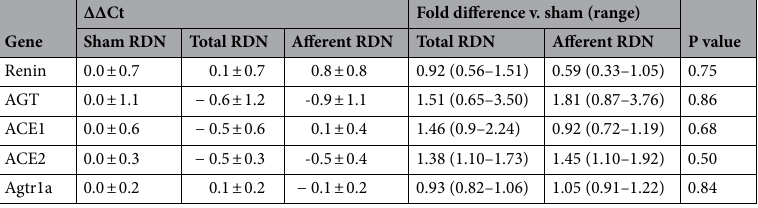
P valueSham RDN Total RDN Afferent RDN Total RDN Afferent RDN